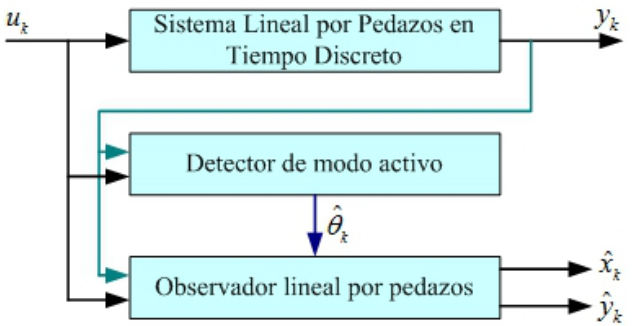
Figure 2. Virtual estimator for piecewise linear